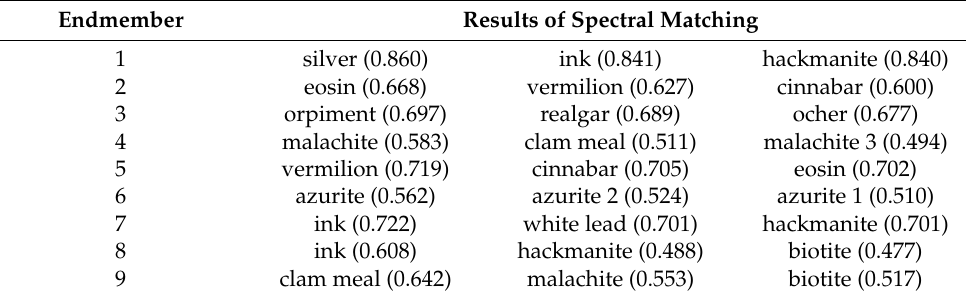
Table 9. The spectral matching and scores for nine endmembers.